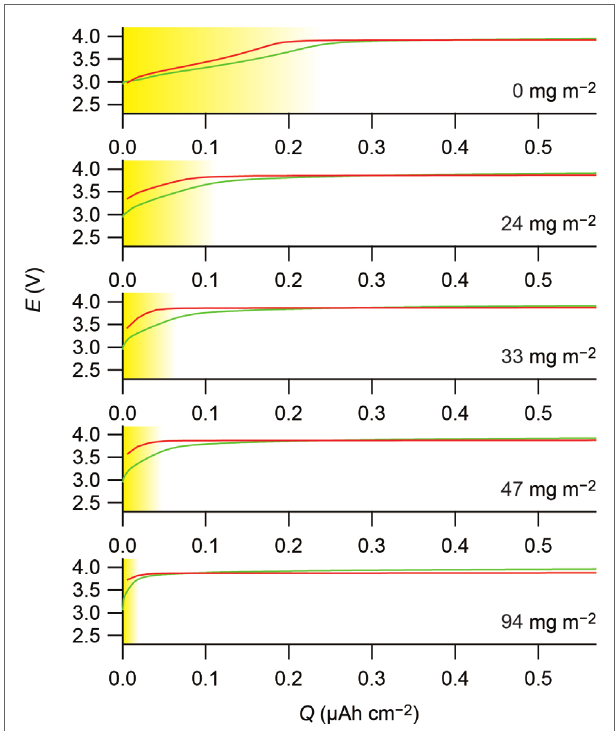
FigUre 2 | The beginning parts of the charge curves of the cathodes . The curves for the In–Li x /Li 1 − x CoO 2 and In–Li x /Li 1 − x Mn 2 O 4 are shown in red and green, respectively. The horizontal axes indicate the charge capacities normalized by the BET surface areas of the active materials, and the vertical axes indicate the cathode potential calculated by adding 0.62 V, which is the electrode potential vs. Li + /Li of the In–Li x counter electrodes, to the cell voltage. The amounts of the LiNbO 3 coated on the active materials are indicated on the basis of the BET surface areas of the active materials in the figures. The potential slopes described in the text are shaded in yellow. Charge curves reported in Ohta et al. (2007) and Takada et al. (2012) are replotted in this figure, copyright © 2007 and 2012, with permission from